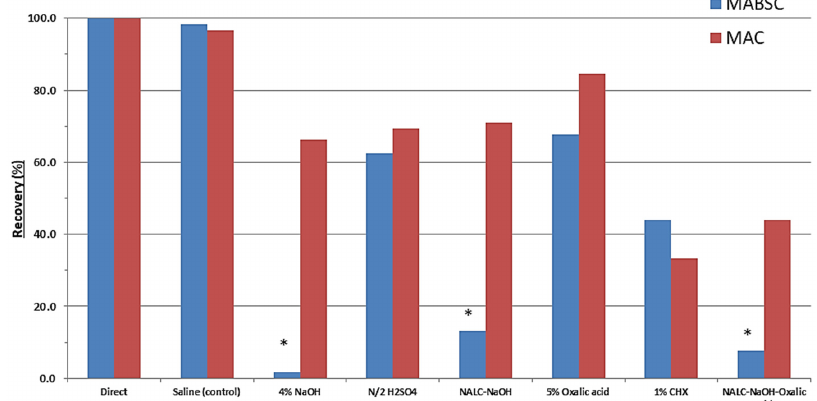
Figure 1. Mean % recovery of MABSC ( n = 30; blue bars) and MAC ( n = 11; red bars) in sputum samples caused by various decontamination treatments, compared to direct inoculation. (* p < 0.05).